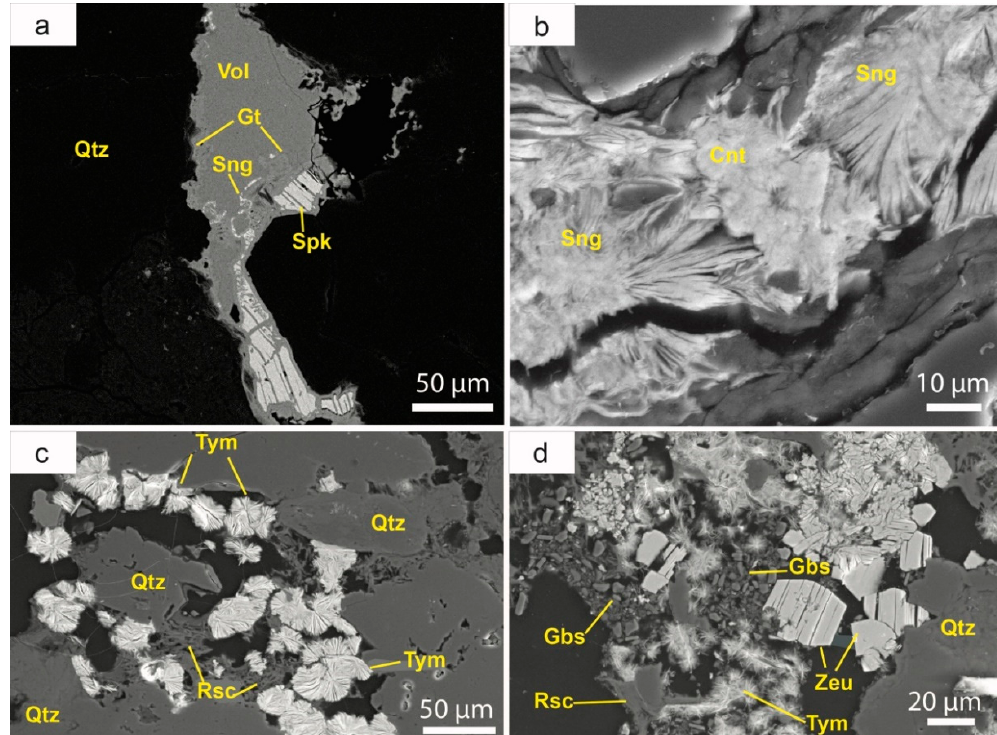
Figure 10. SEM images (BSE mode) showing the textures of the uranyl vanadates of the carnotite group. ( a ) Spionkopite (Spk) in secondary porosity interstitial to detrital quartz (Qtz) and replaced by goethite (Gt), followed by sengierite (Sng) and finally volborthite (Vol) crustiform growths; ( b ) Veinlet in roscoelite with sengierite (Sng) replaced by carnotite (Cnt); ( c ) Vuggy porosity in detrital quartz (Qtz) and roscoelite (Rsc), filled by tyuyamunite (Tym); ( d ) Secondary porosity in quartz and roscoelite filled by gibbsite (Gbs) and tyuyamunite platelets (Tym), followed by zeunerite (Zeu). Tyuyamunite [Ca(UO 2 ) 2 (VO 4 ) 2 · 5–8H 2 O] and carnotite crystallized during late weathering